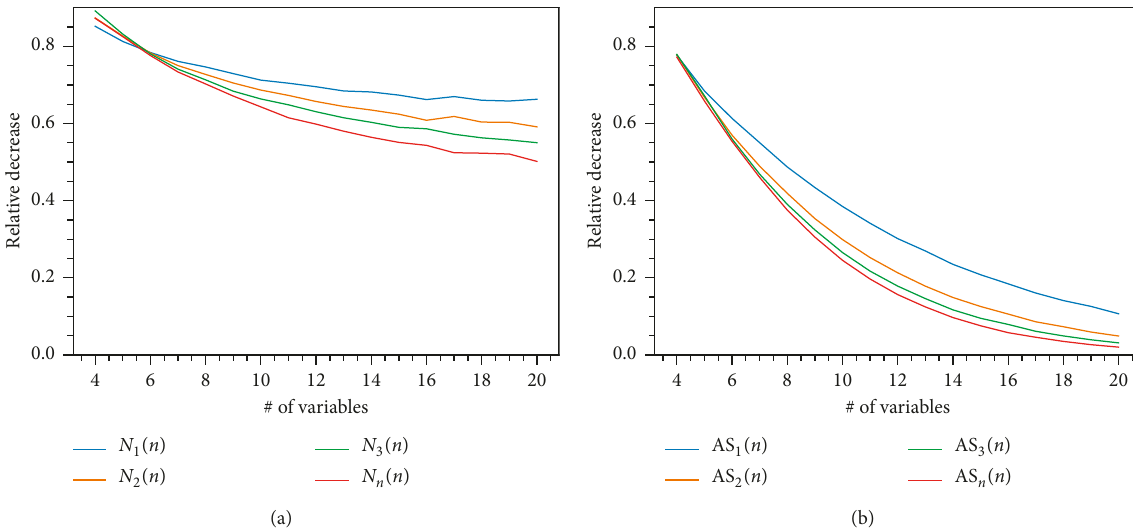
Figure 3: Dependence of the relative decreases of the sample means of N ( f ) and AS ( f ) on the number of variables n . (a) Relative decrease of the number of attractors. (b) Relative decrease of the average size of an attractor.